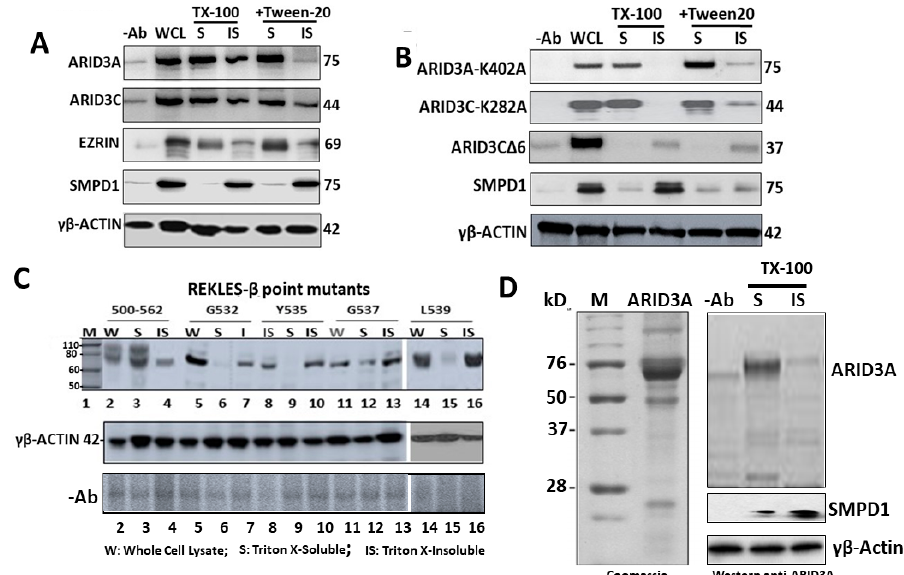
Figure 3. ARID3A and the related paralogue ARID3C localize within monomeric globular (G)-actin via the conserved REKLES- β domain. ( A ) ARID3A and 3C transfected COS7 lysates were processed via Triton X-100 and/or TritonX- 100+Tween 20 fractionation into insoluble (IS, filamentous (F)-actin) or soluble (S, G-actin) proteins. After fractionation by SDS-PAGE, samples were Western blotted with the indicated Abs; anti-SMPD1 served as an IS positive control and actin inputs were equalized with pan-actin. ARID3A and 3C partitioned primarily within the G-actin fraction. ( B ) Loss of the REKLES domain (ARID3A-d(521541) and ARID3C ∆ 6), but not SUMO-I binding motifs (ARID3A-K402A or ARID3C-K284A) abolished partitioning into the soluble G-actin fraction. ( C ) A region within REKLES- β (amino acids 532–540 and indicated on Figure S6B) contains a cluster of conserved residues (G532, Y535, G537, and L539) whose point mutation significantly reduced or abolished ARID3A association with G-actin. ( D ) Bacterially purified ARID3A segregated within soluble G-actin. Left: SDS-PAGE Coomassie-stained image of bacterial ARID3A following purification as detailed in the Materials and Methods. Right: SDS-PAGE Western blot of TX-100 soluble (S) and insoluble (IS) fractions blotted with the indicated probes. SMPD1, marker for the insoluble fraction; γβ -actin, loading